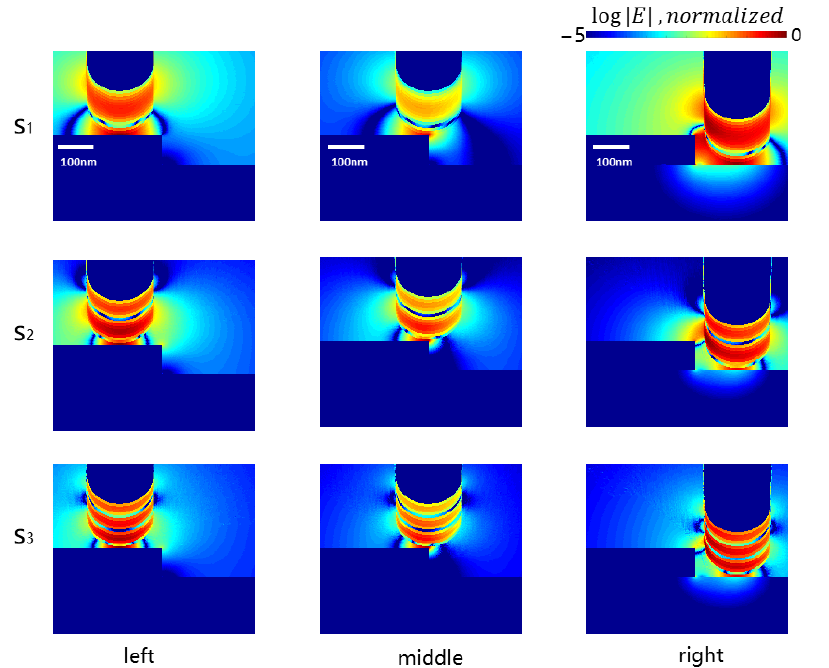
Figure 8. The near-field electric field image for three typical positions of tip corresponding to edge effect in s-SNOM.